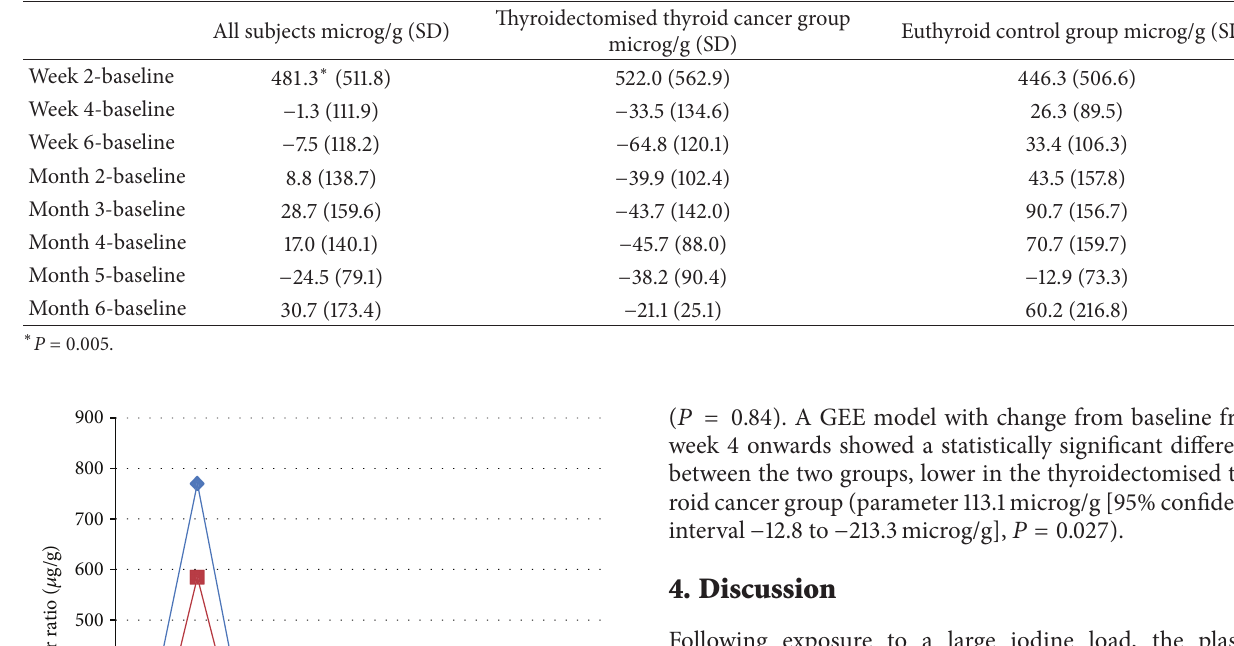
Table 2: Urinary iodine creatinine ratio change from baseline (microg/g).